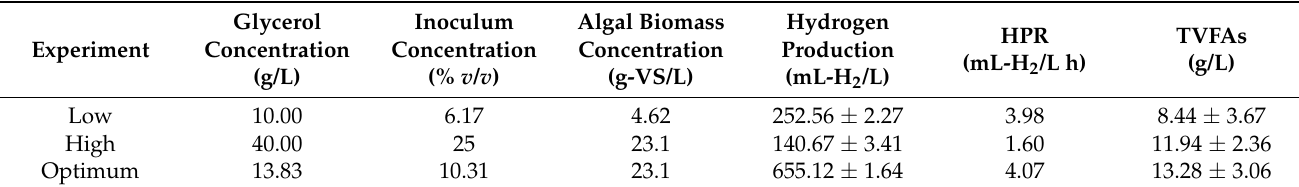
Table 3. Hydrogen production, HPR, and total volatile fatty acid (TVFAs) production at low, high, and optimal conditions from codigestion of crude glycerol and algal